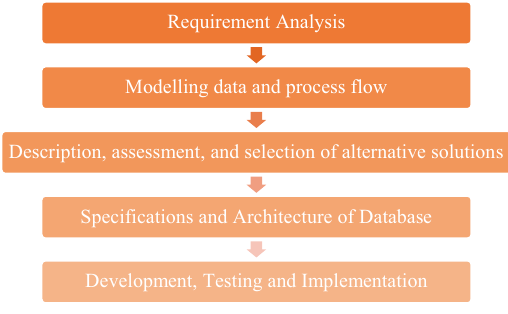
Figure 1. Data integration process (adapted from Woldesenbet, Jeong and Park, 2016) DETERMINATION OF CRITERIA DATA FOR